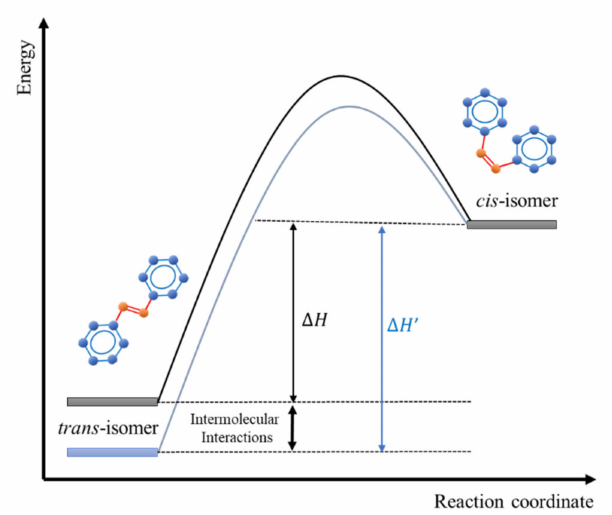
Figure 3. Increasing the storage energy in azobenzene molecular solar thermal storage systems by intermolecular